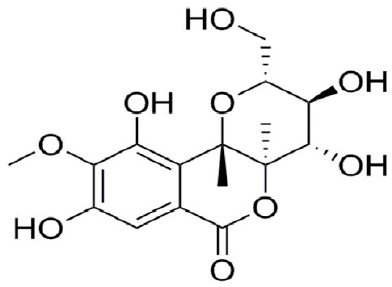
Figure 6. The chemical structure of bergenin.